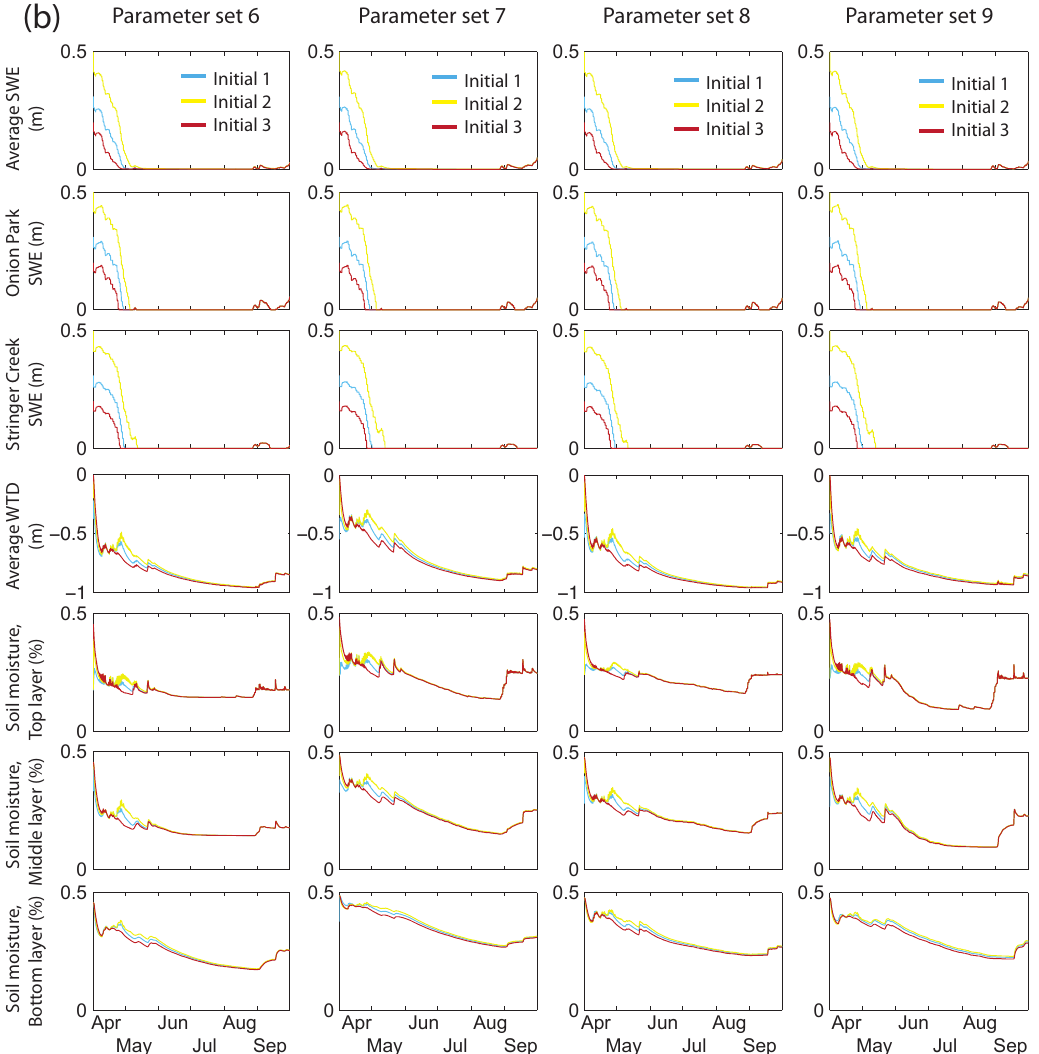
Figure A1. Predictions of several watershed-averaged water balance components during model initialization (1 April 2006 through 30 September 2006) for nine equifinal parameter sets. Color indicates three different values for initialization, with initial values for wa- ter balance components corresponding to the value shown on 1 April. (a) contains parameter sets 1 through 5 and (b) contains parameter sets 6 through